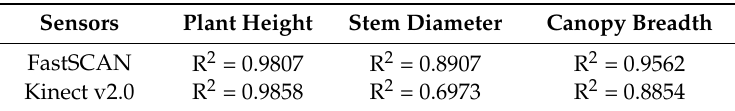
Table 3. Comparison of accuracy for the two devices.